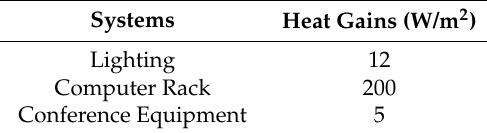
Table 6. Office system internal heat gains (W/m 2 ).